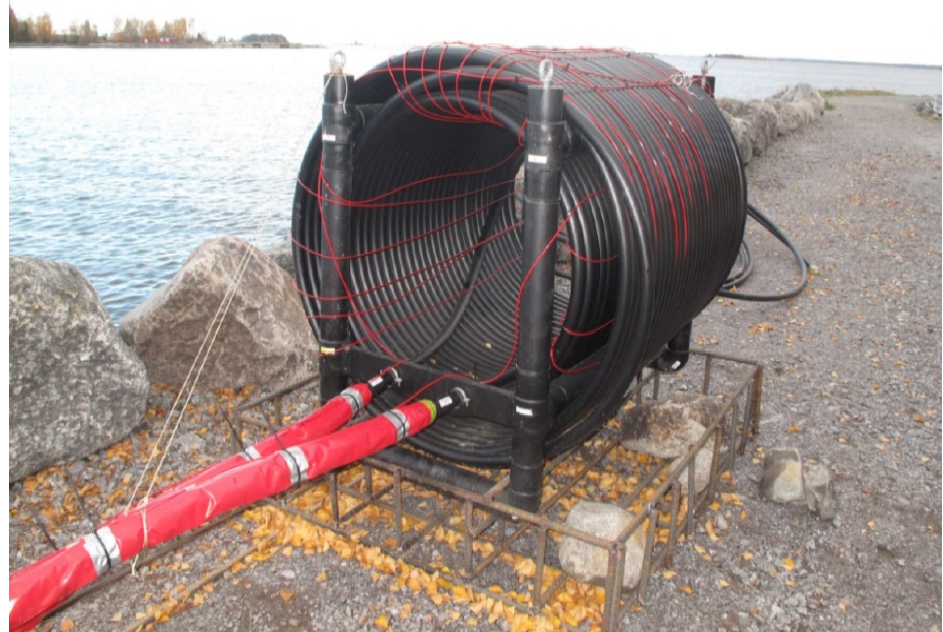
Figure 3. The water heat exchanger that was planned to be installed in Merten Talo is connected to the tubes (of the heat pump in the home), which are insulated. The red wire is the temperature sensors (Picture taken by Anne Mäkiranta during installation process 18 October 2018).